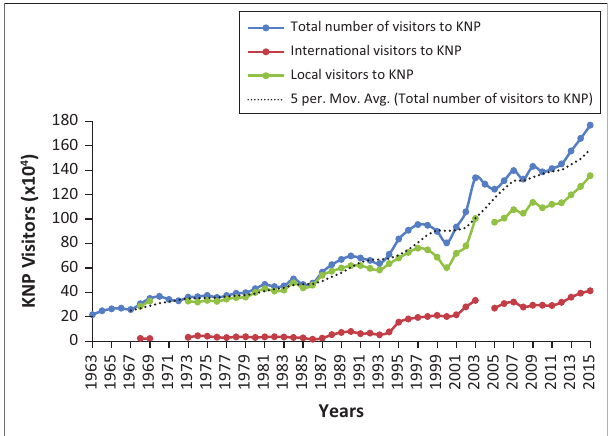
FIGURE 3: Visitors to Kruger National Park.